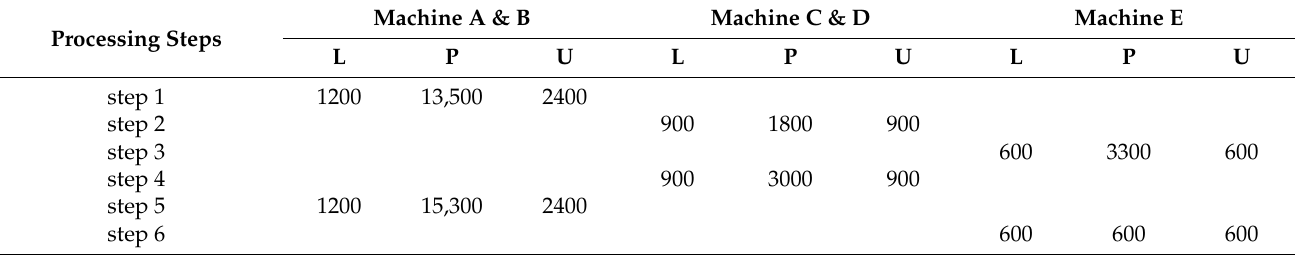
Table 1. Processing steps, machine eligibilities, and time information for the Intel minifab